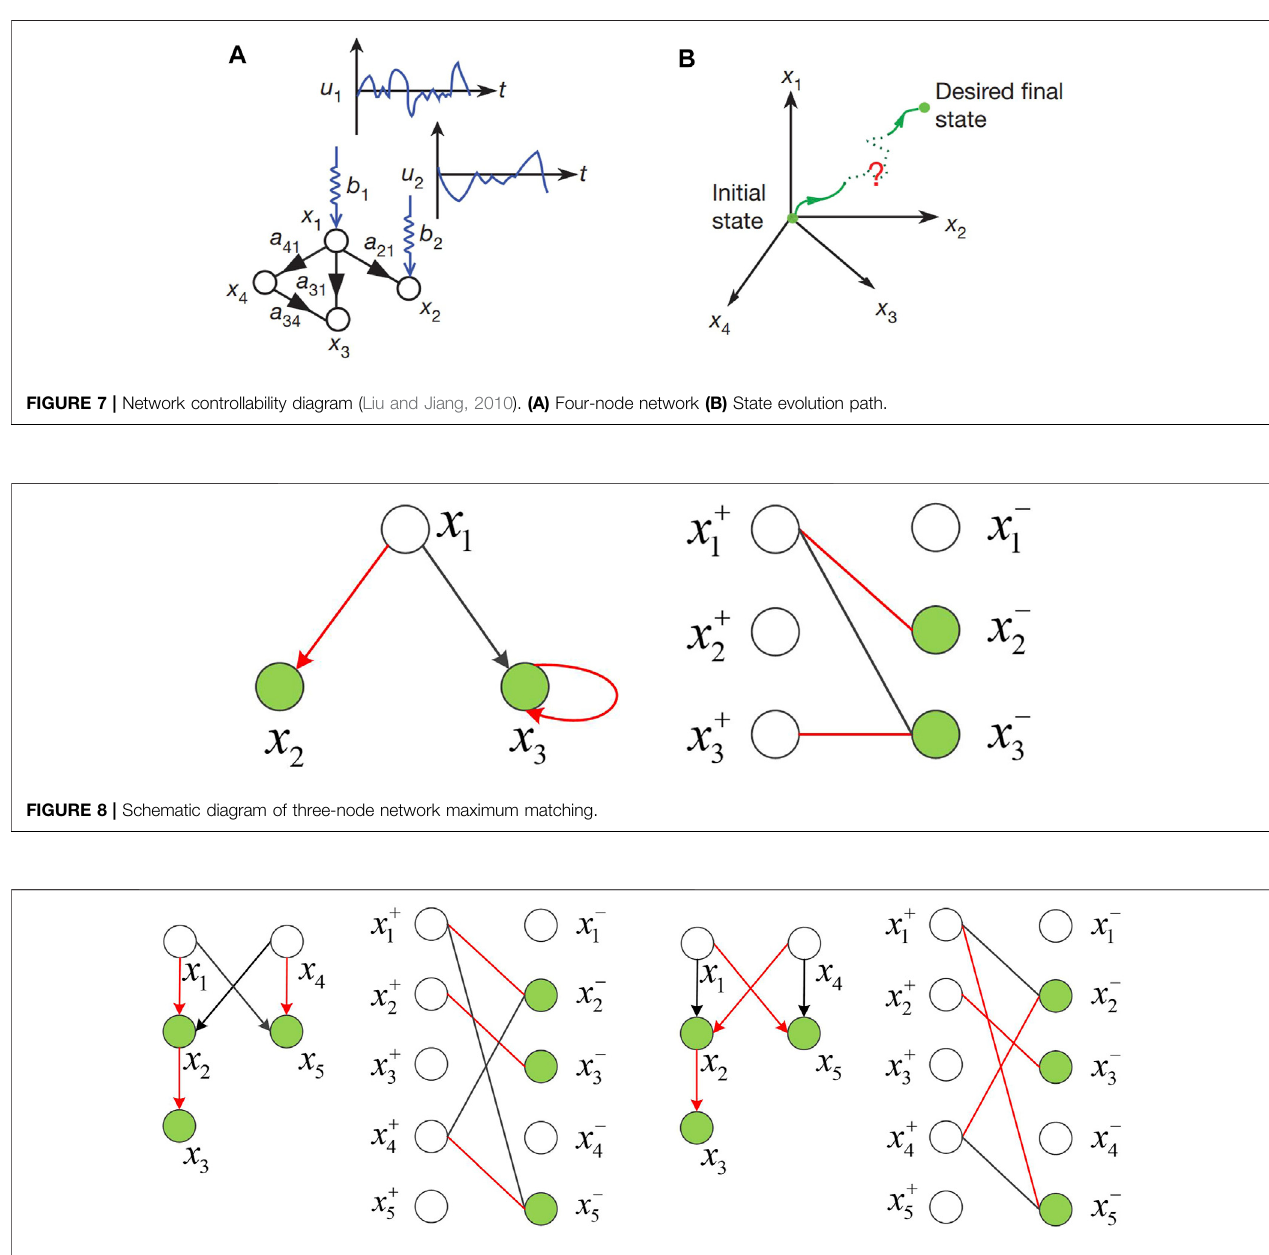
FIGURE 9 | Schematic diagram of fi ve-node network maximum matching. (A) Maximum matching one (B) Maximum matching two.